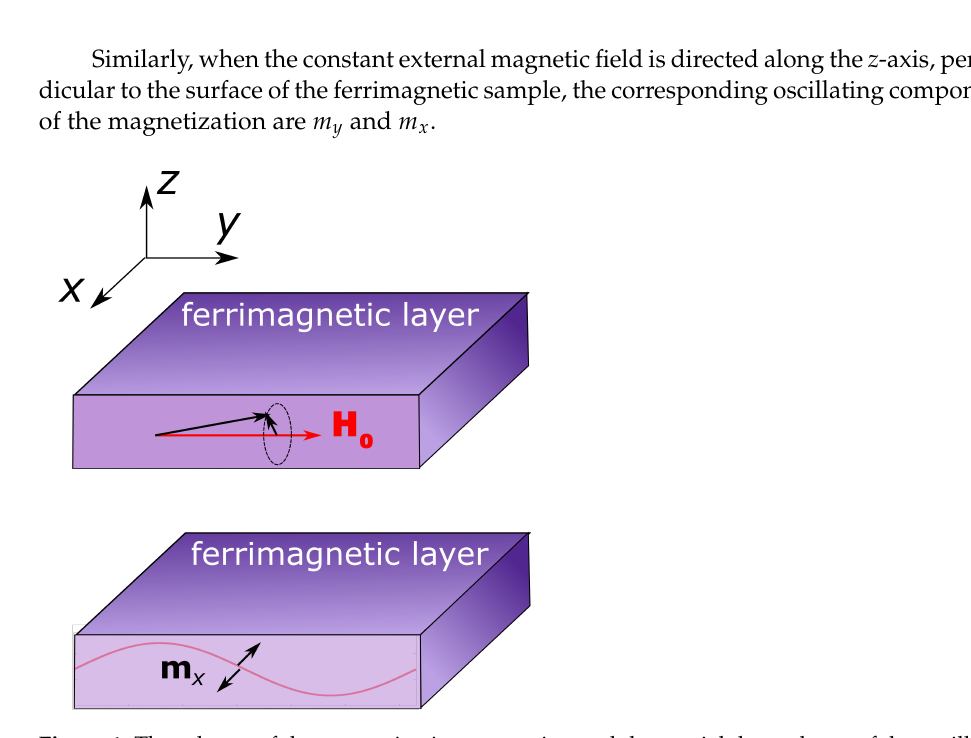
Figure 1. The scheme of the magnetization precession and the spatial dependence of the oscillating component of the magnetization m x